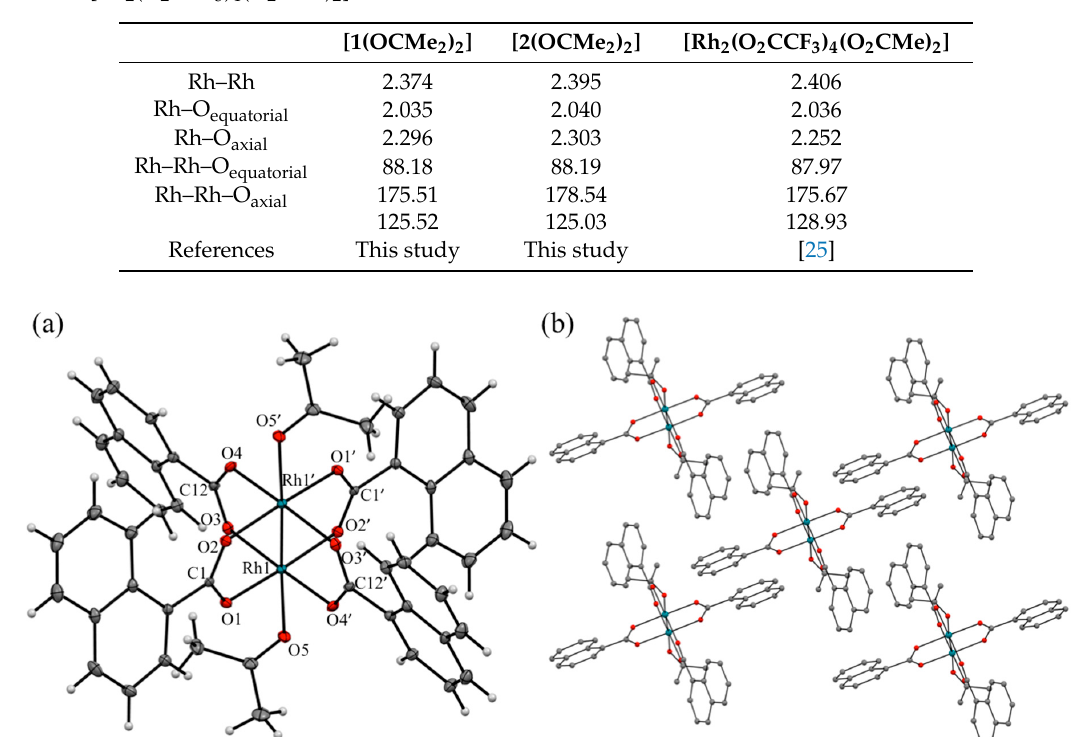
Table 2. Selected (averaged) structural parameters of crystal structures of [1(O 2 CMe 2 ) 2 ] , [2(O 2 CMe 2 ) 2 ] , and [Rh 2 (O 2 CCF 3 ) 4 (O 2 CMe) 2 ].